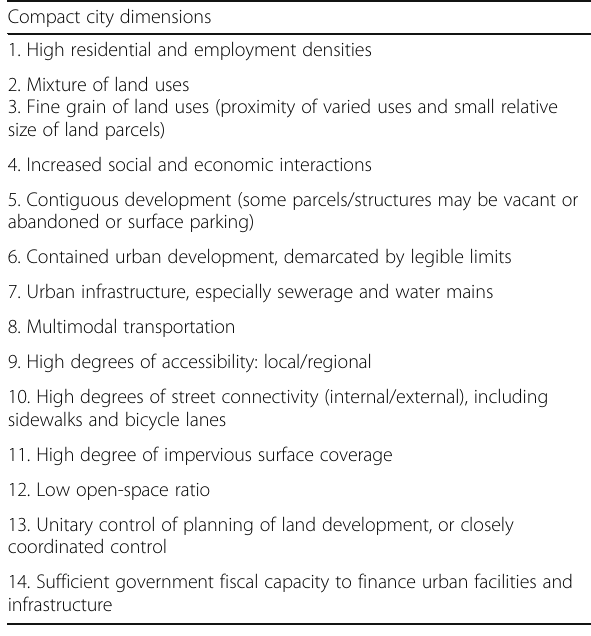
Table 2 Compact city dimensions. Source: Neuman